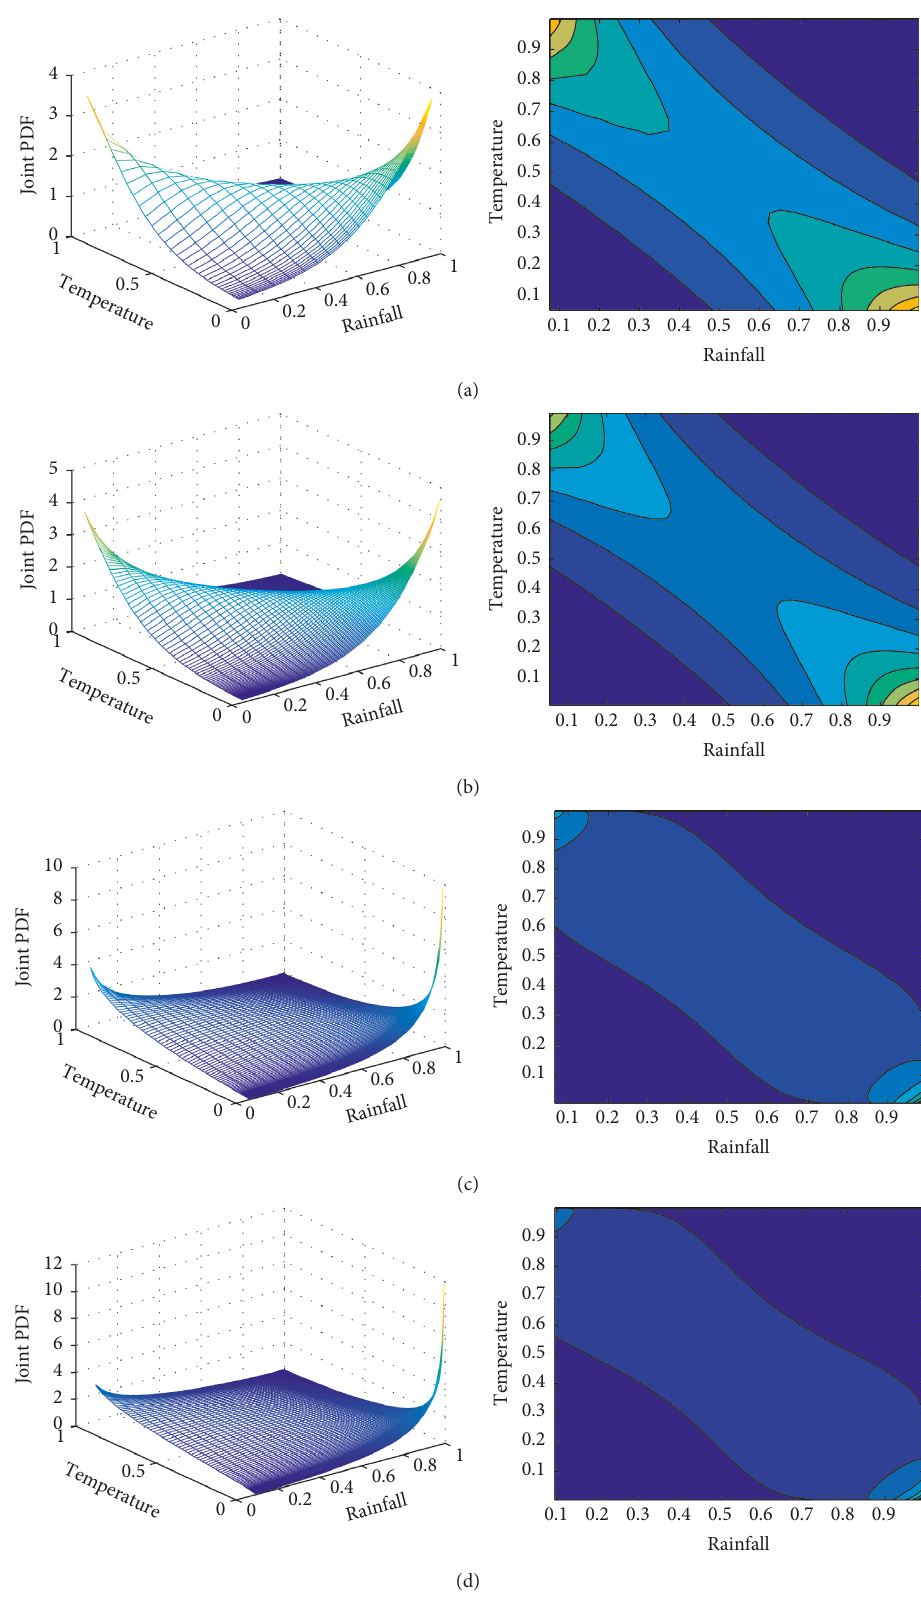
Figure 6: The joint PDF and corresponding contour lines for (a) historical period, (b) RCP2.6, (c) RCP4.5, and (d)